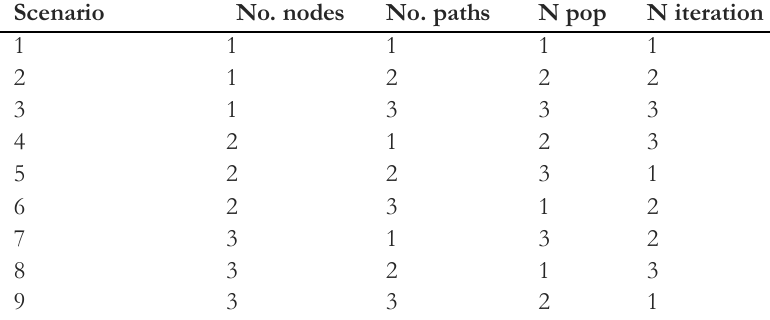
Table 13. Problem scenario